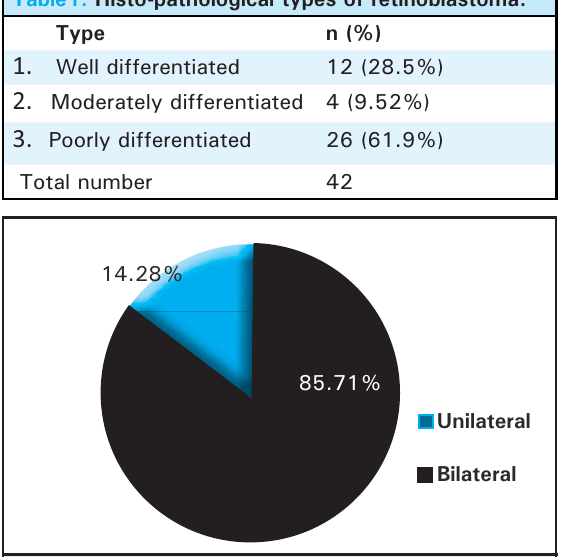
Table1. Histo-pathological types of retinoblastoma.